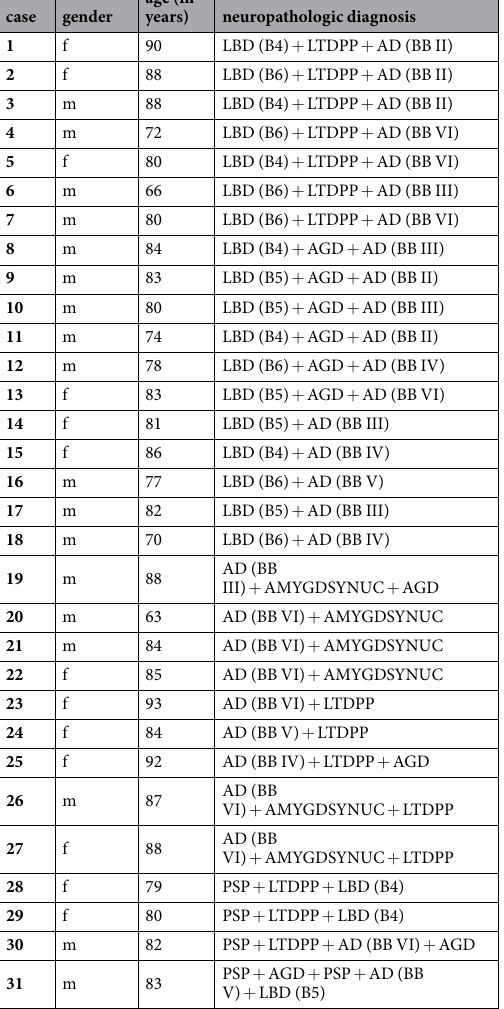
Table 1. Demographic data. AD, Alzheimer disease-related neurofibrillary tangle pathology; AGD, argyrophilic grain disease; AMYGDSYNUC, α -synuclein inclusions restricted to the amygdala; B, Braak stages of α -Syn deposition; BB, Braak and Braak stages of NFT deposition; LBD, Lewy body disease indicating either PD or DLB; f, female; m, male; PD, Parkinson disease; PSP, progressive supranuclear palsy; LTDPP, limbic TDP- 43 proteinopathy.